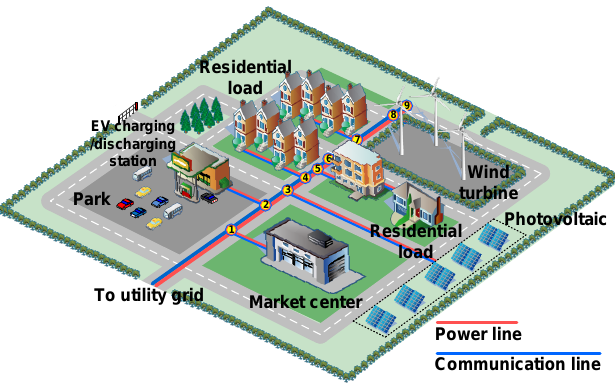
Figure 1. System model of 9-node residential